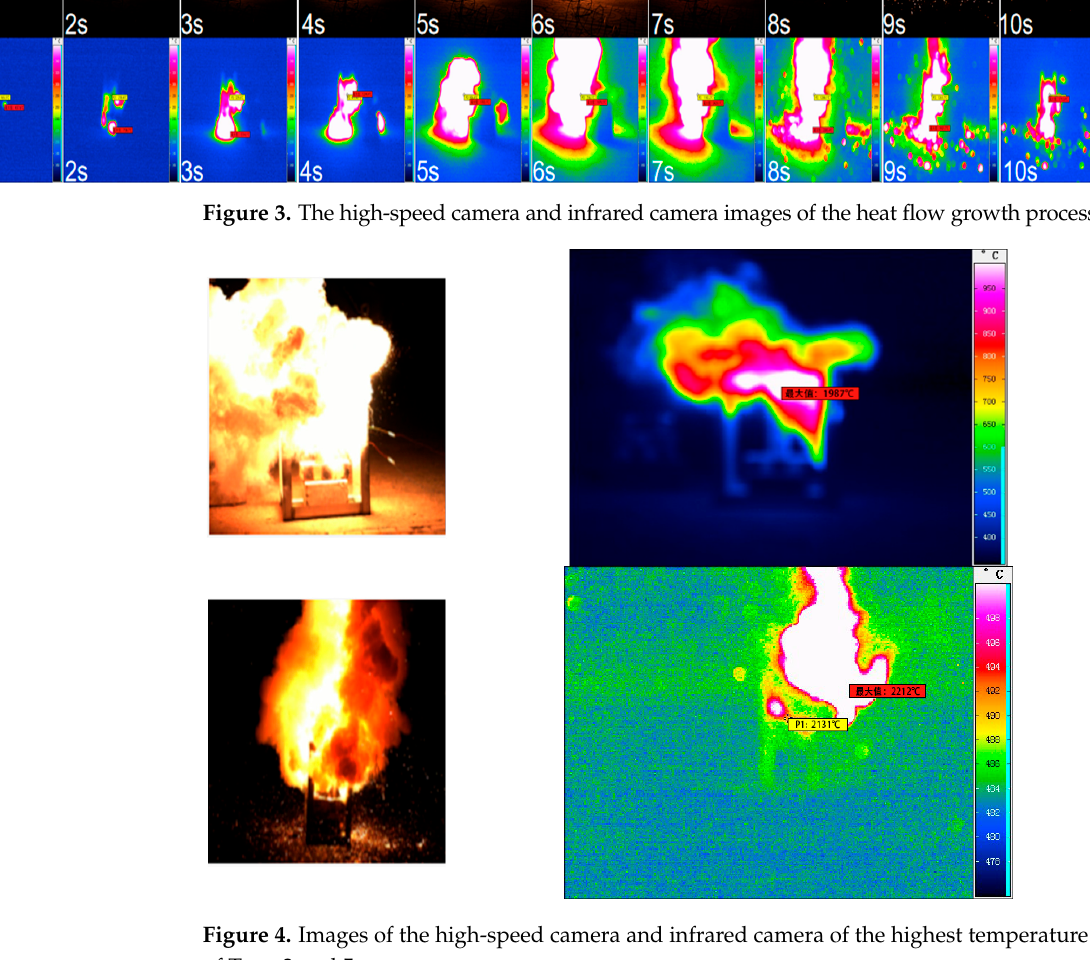
Figure 3. The high-speed camera and infrared camera images of the heat flow growth process of Test 3.